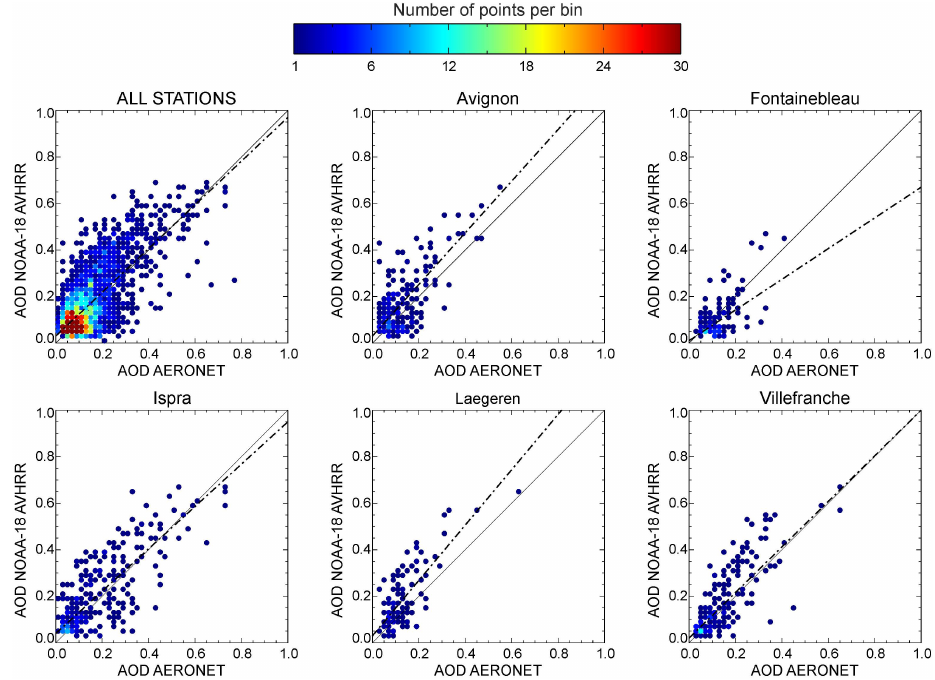
Fig. 4. Same as Fig. 3 for NOAA-18